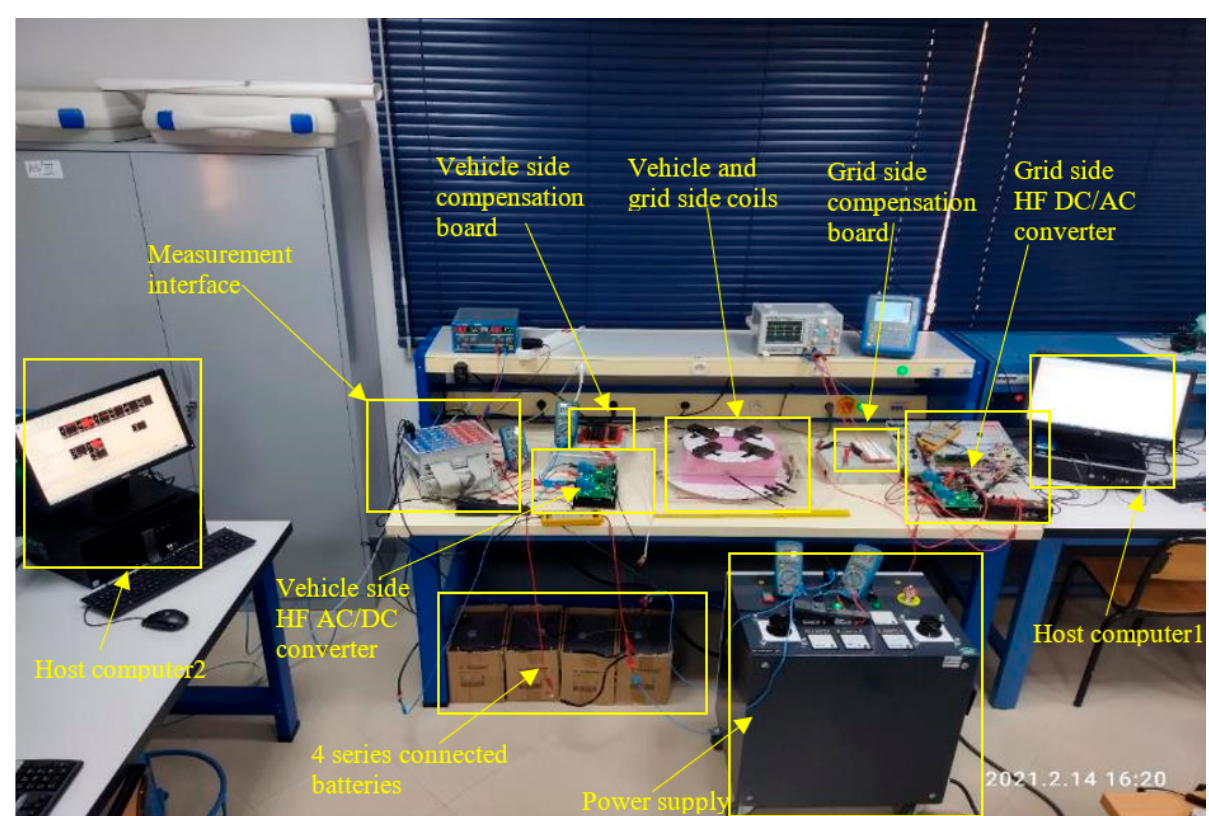
Figure 23. Overall setup of the realized DC–DC WPT charger.